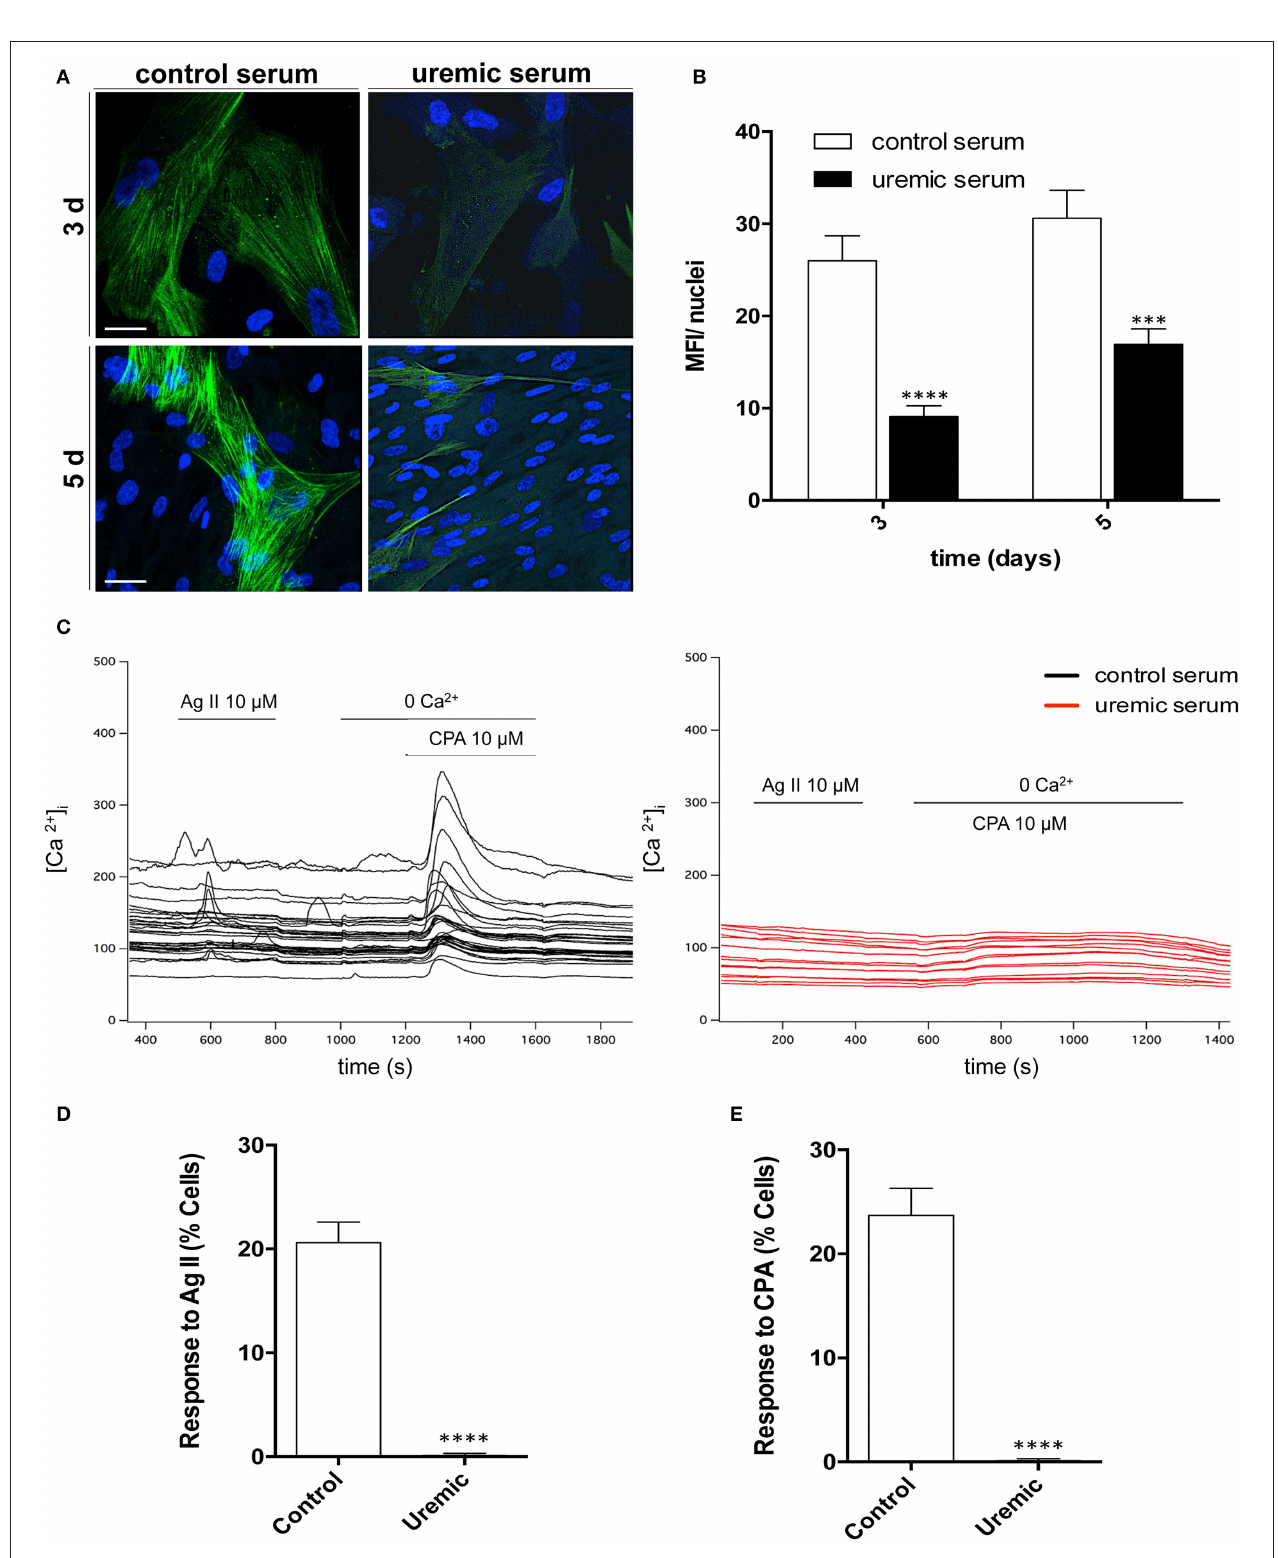
FIGURE 6 | Uremia decreases expression of contractility markers, blunts receptor-operated channel response and depletes intracellular Ca 2 + stores. (A) Representative micrographs of HASMC treated with control or uremic serum, fixed, and stained with anti- α -SMA antibody (green). Nuclei were counterstained with